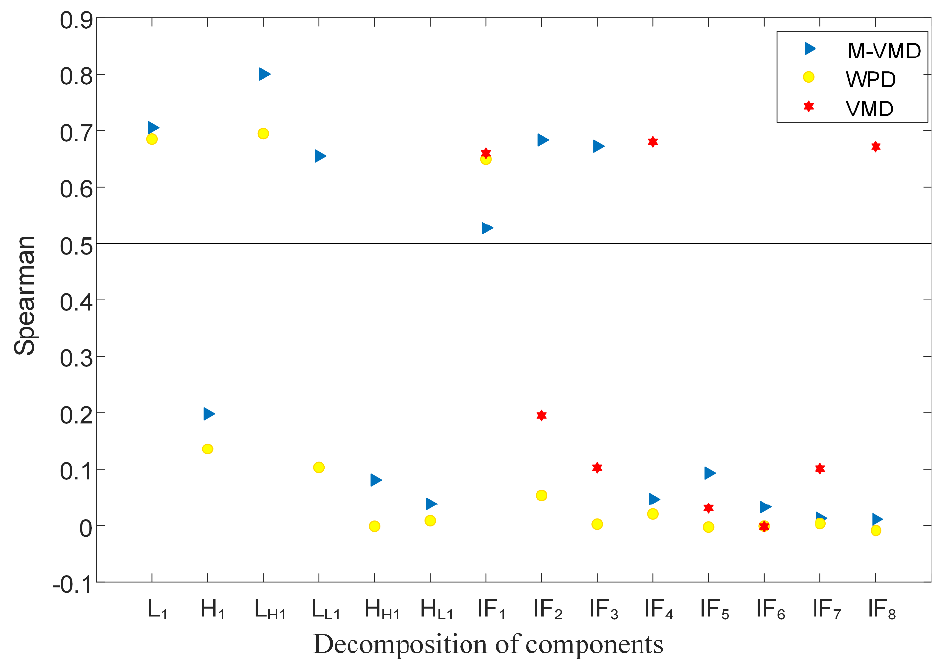
Figure 3. Scatter plot of Spearman decomposition components and output power correlation coeffi- cient of different models.